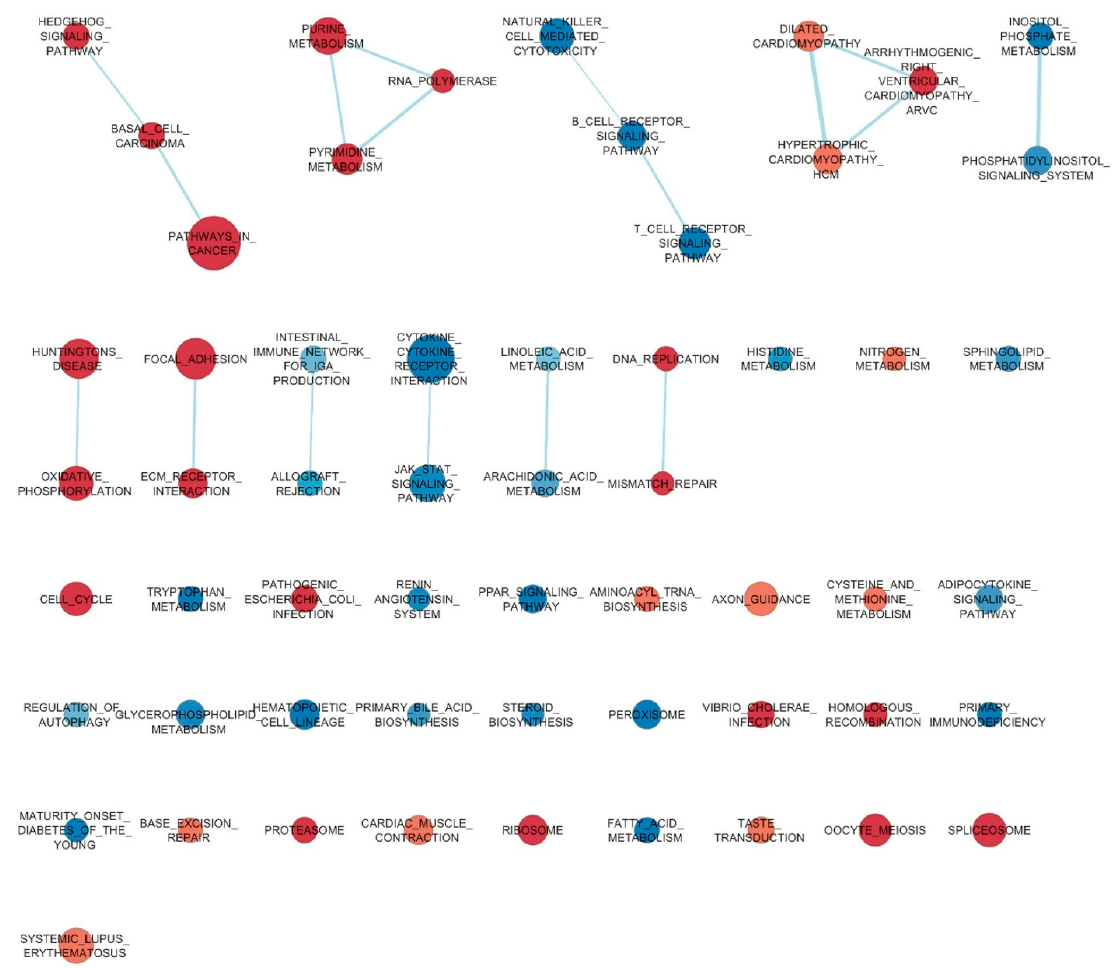
Figure 4. Enriched gene sets in the jejunum and cecum of broiler chickens at 42 days of age. Nodes represent gene sets enriched in the jejunum (red color) and cecum (blue color). Node size represents the number of genes in each gene set. Node cut-off with an FDR q-value of 0.10. The nodes were joined if the overlap coefficient was ≥ 0.4.